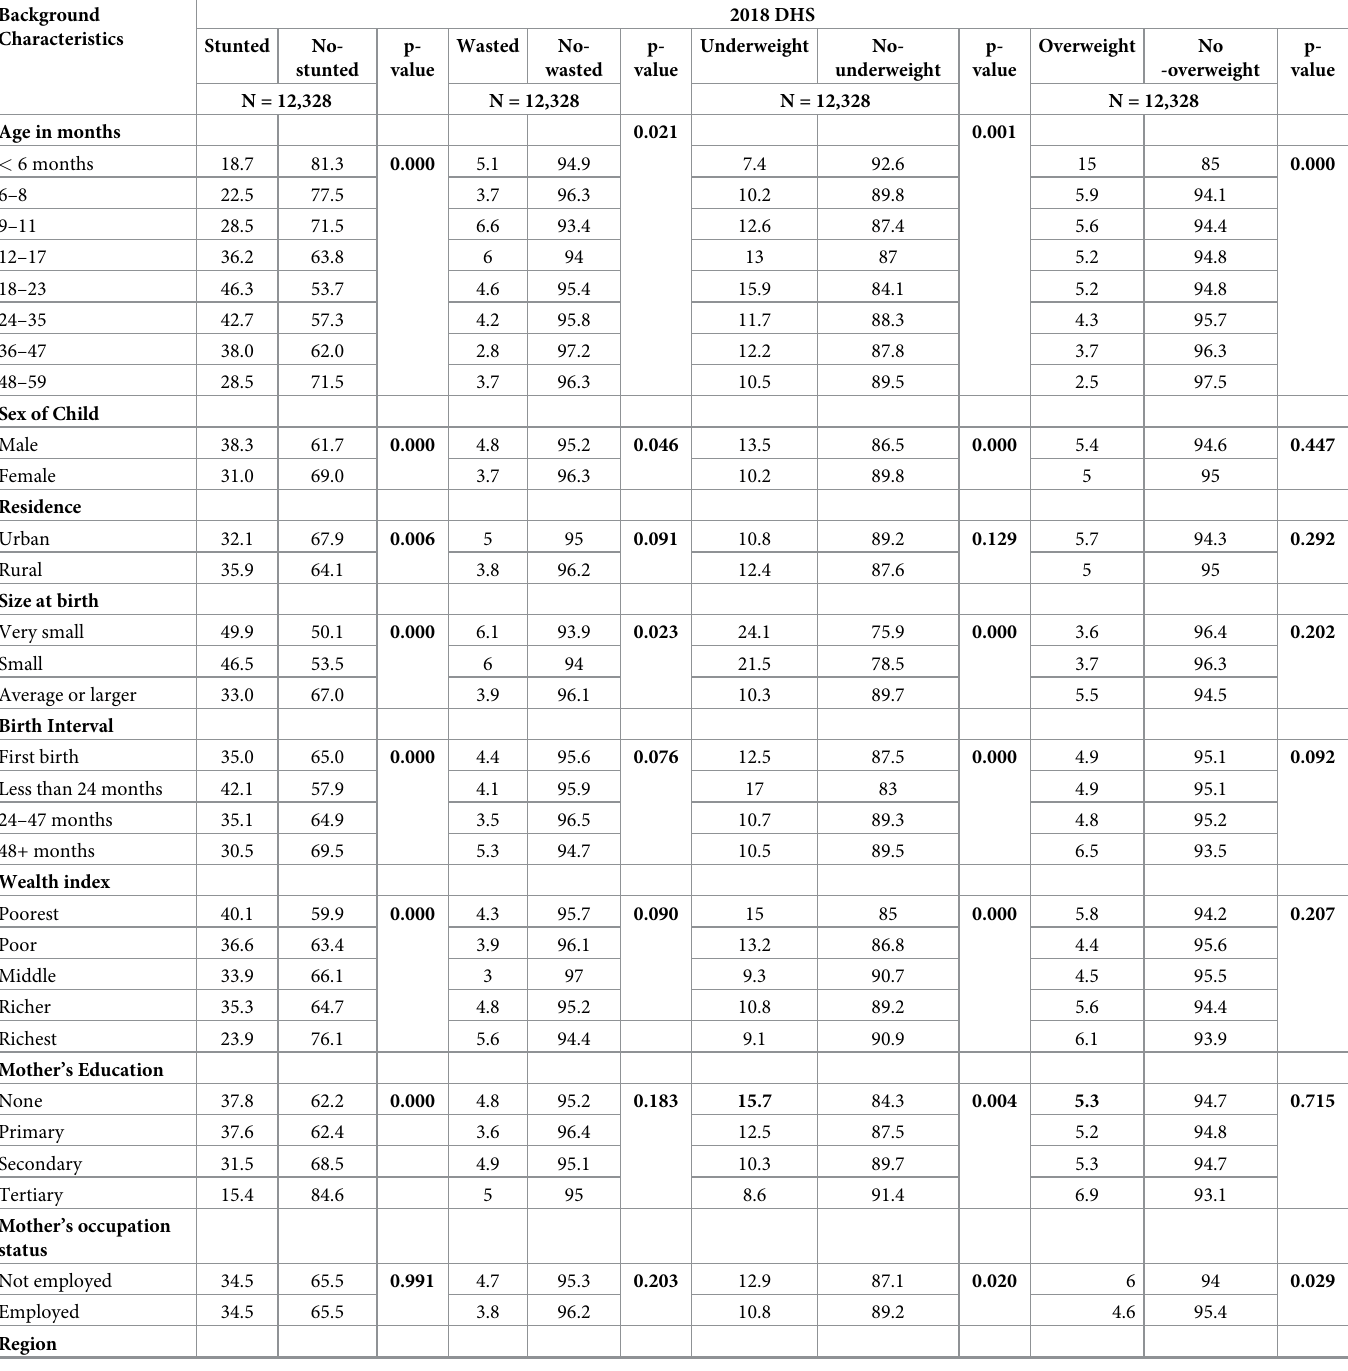
Table 2. Bivariate analysis of childhood malnutrition indicators with background characteristics (2018 DHS data). Background